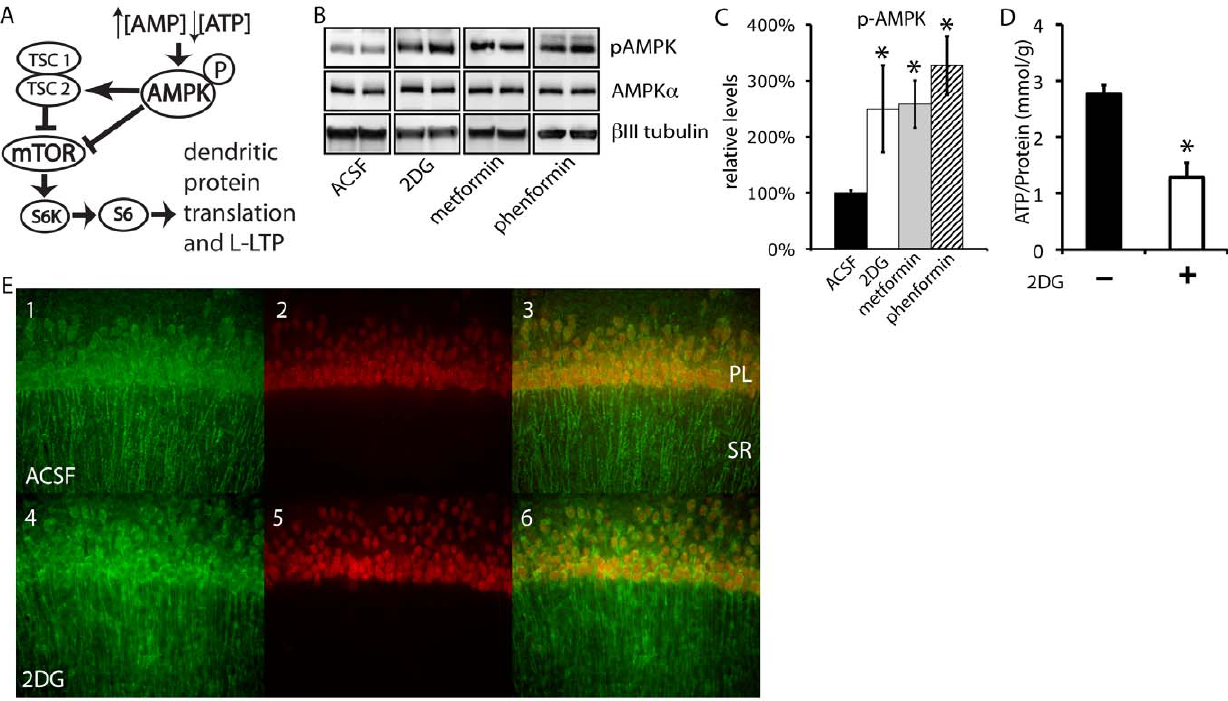
Figure 1. Metformin and 2DG activate AMPK in hippocampal CA1 neurons. A) Schematic of the AMPK-mTOR pathway. B) AMPK is activated 30 min after exposure to 2DG (10 mM, p=0.019, n=9), metformin (5 m M, p=0.005, n=6), or phenformin (10 m M, p=0.018, n=6). Hippocampal slices were incubated in ACSF and drug for 30 minutes and subjected to western blot with anti-phospho-Thr172-AMPK antibody followed by b III-tubulin as a loading control. Representative western blots of duplicate lanes are shown, together with their quantification from at least 10 samples per condition (C). D) ATP levels are reduced in the presence of 10 mM 2DG. Slices were incubated in ACSF + 10 mM 2DG (n=3) as above. Tissue was lysed and subjected to a CellTiter-Glo ATP assay (Promega). E) 2DG activates AMPK in cell bodies of the pyramidal layer (PL) and dendrites of the stratum radiatum (SR). Anti-phospho-Thr172-AMPK immunoreactivity is displayed in green. Neu-N is displayed in red. Scale bar: 10 m m.